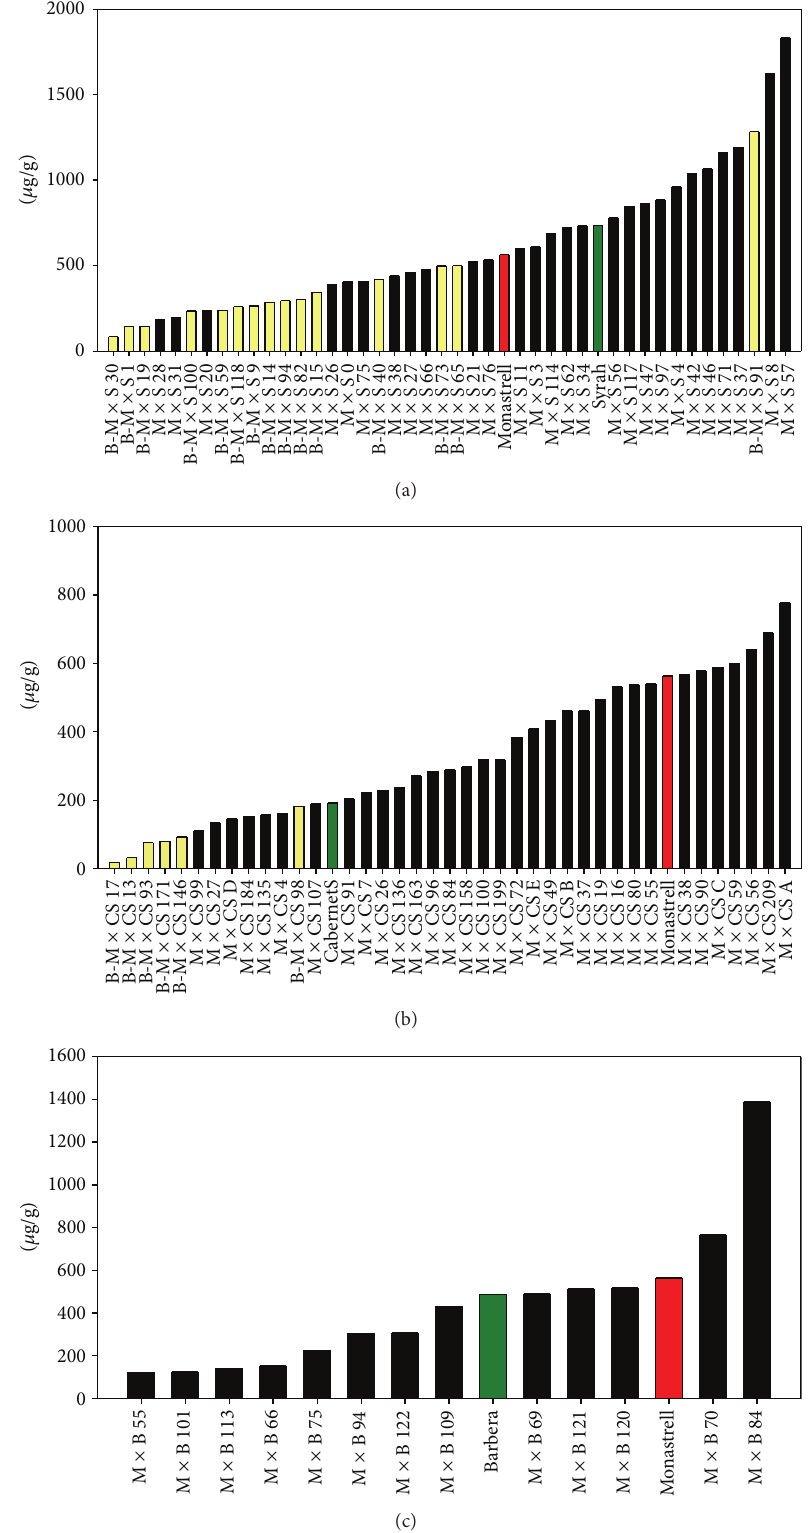
Figure 4: Concentration of flavonols in Monastrell × Syrah (a), Monastrell × Cabernet Sauvignon (b), and Monastrell × Barbera (c) hybrid grapes (yellow bars indicate white grape bearing